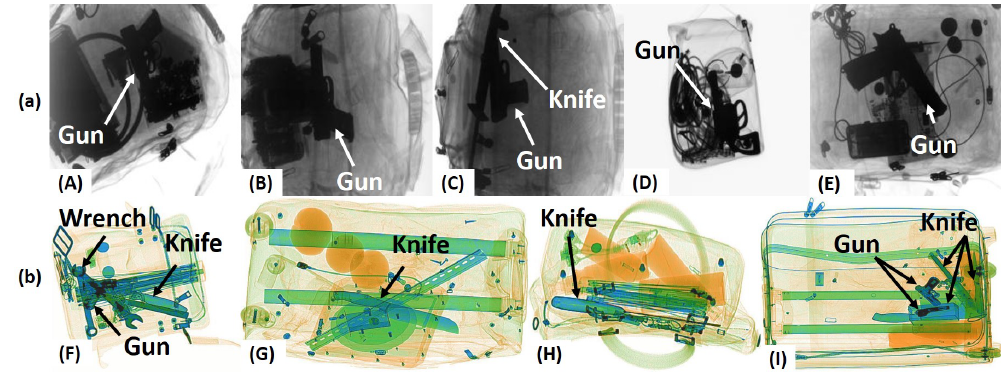
Figure 1. (( A )–( I )) Baggage X-ray scans containing extremely cluttered and overlapping contraband items such as guns , knives and wrenches . Row ( a ) shows the scans from the GDXray [15] dataset and row ( b ) shows the scans from the SIXray [14]